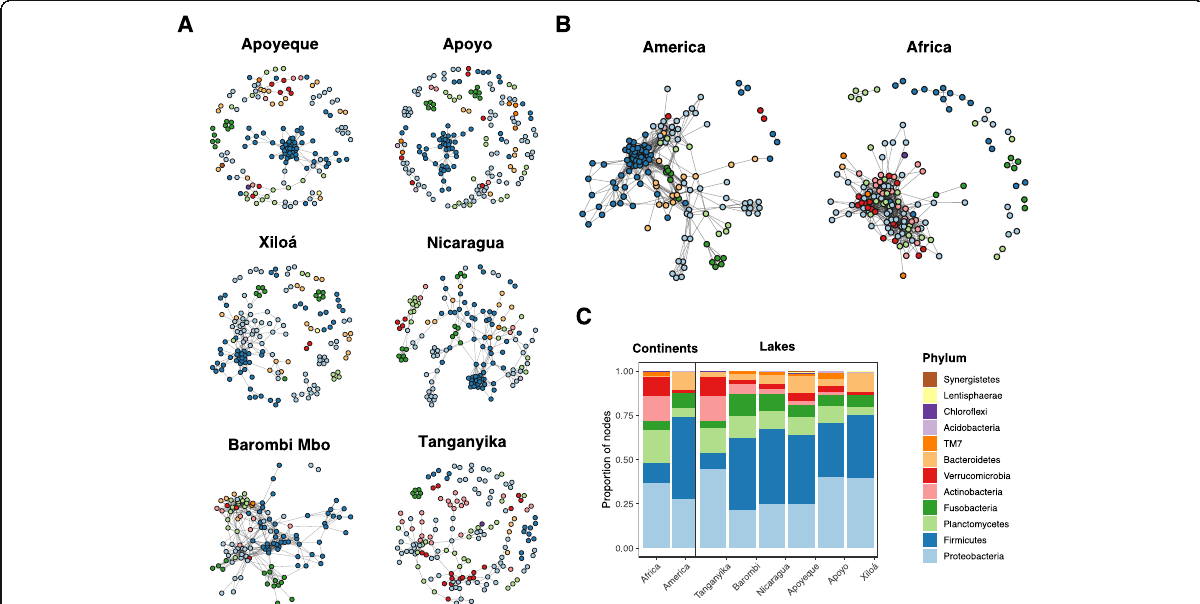
Fig. 1 Co-occurrence network graphs of the cichlid gut microbiota and their node taxonomic composition. a-b Networks for individual lake assemblages ( a ) and continental datasets ( b ), where nodes are OTUs color-colored to the phylum level. c Proportion of nodes (OTUs) per phylum found in each geographical dataset (for the overall microbial taxonomic composition, see [24], while for proportion of OTUs per phylum in the input dataset see Additional file 4: Figure S3). All American networks largely resembled in topology and node taxonomic content. Note the dense cluster of Firmicutes nodes present in all lake networks (blue circles, in L. Tanganyika the cluster is highly reduced), encompassing the two families Clostridiaceae and Peptostreptococcaceae (for family level, see Additional file 2: Figure S1). Network interactions were inferred based on concordance among four co-occurrence measures in the ensemble package CoNet [25] and visualized with igraph